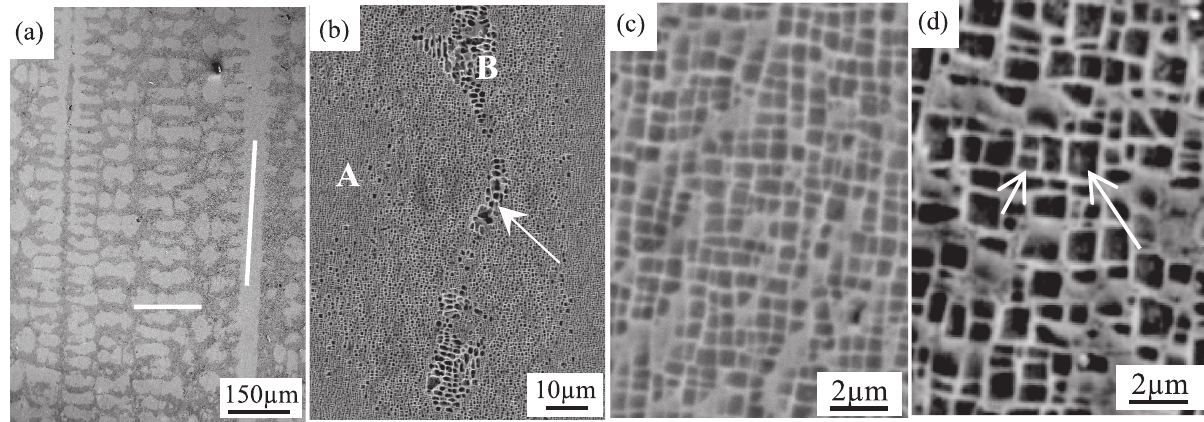
Fig. 1: Microstructure in the local region of the alloy after full heat treatment. (a) Dendrite morphology on (100) plane, (b) magnified morphology in the dendrite/inter-dendrite region, (c) fine cubical g′ phase in the dendrite region, (d) coarser cubical g′ phase in the inter-dendrite region